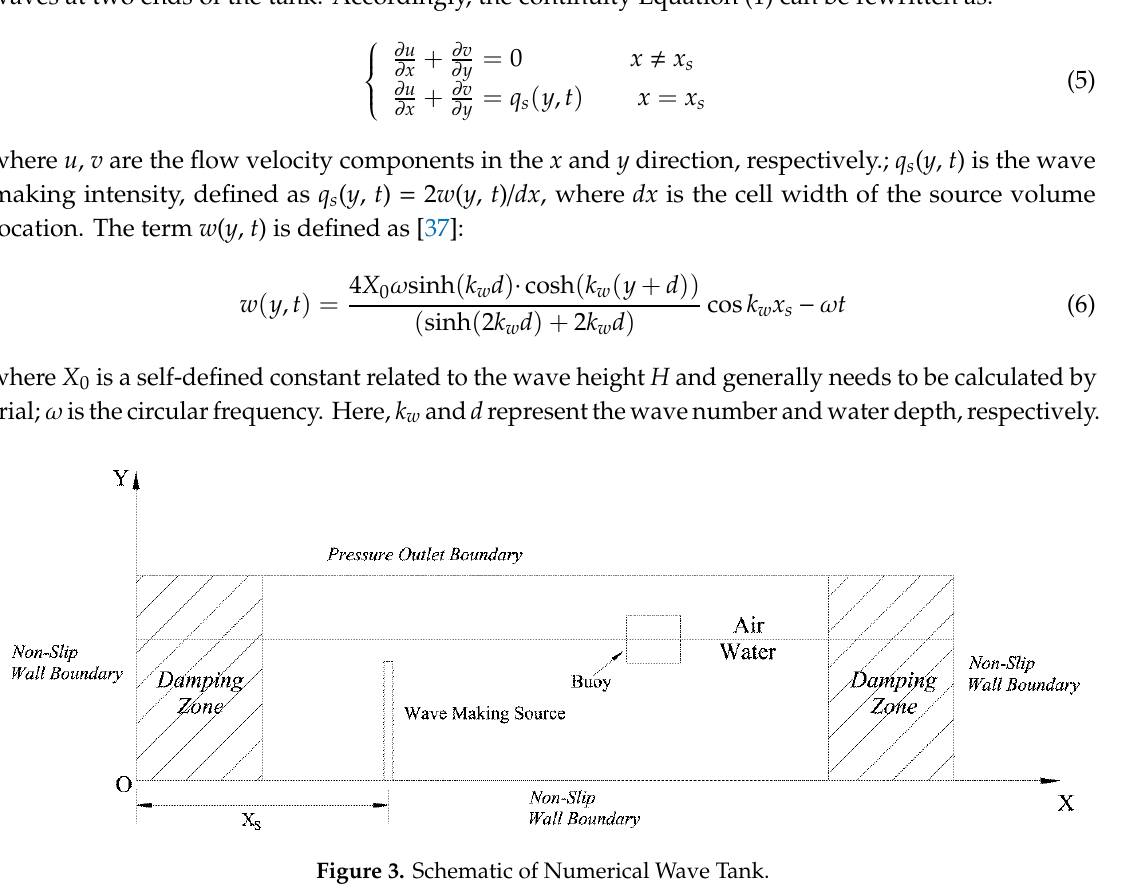
Figure 2. Mesh structures of numerical wave tank (NWT).